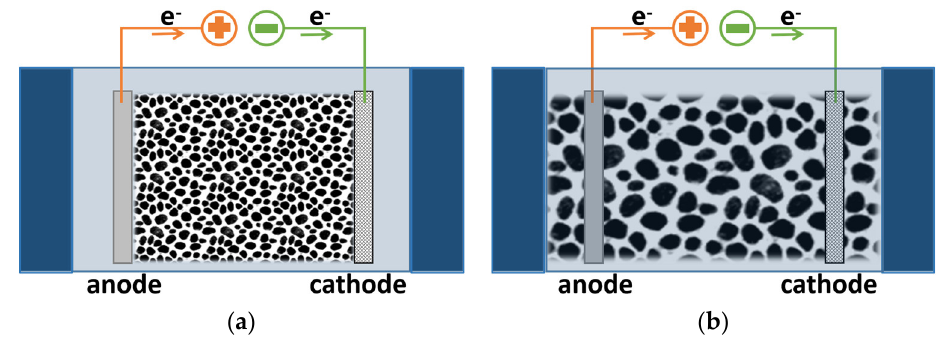
Figure 6. The structure of 3D-ECR.